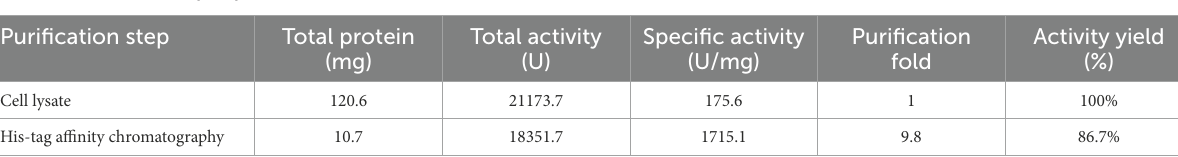
TABLE 1 Purification of